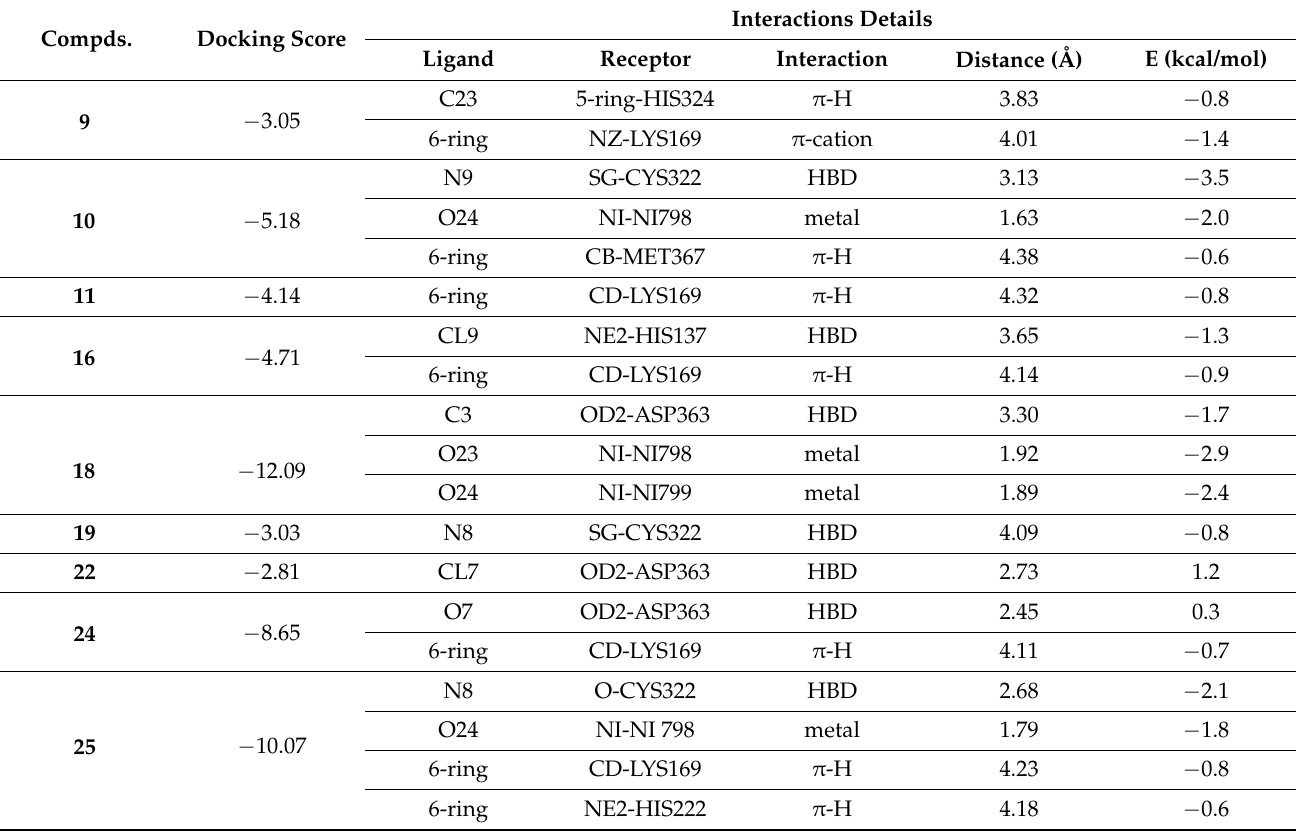
Table 8. Docking scores (S) and Interactions Detail of the selected active compounds ( 9–11, 16, 18, 19, 22, 24, and 25 ).